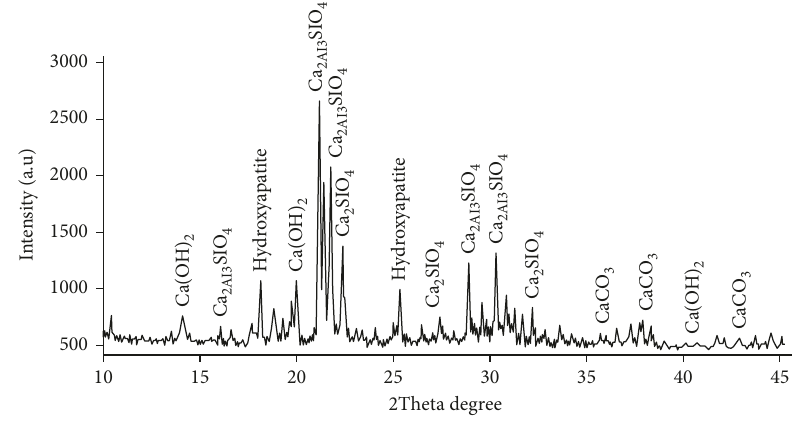
Figure 5: XRD of AA6061+15 wt% snail